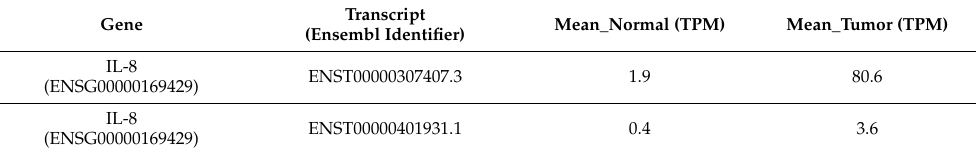
The table lists two transcripts for the IL-8 gene (Ensembl gene identifier: ENSG00000169429). Expression values were obtained from the GTEx and PCAWG resources for normal colon tissues and CRC samples, respectively. Full sets of transcript abundance for the IL-8 isoforms are available in Supplementary File S1. TPM, transcript per million.